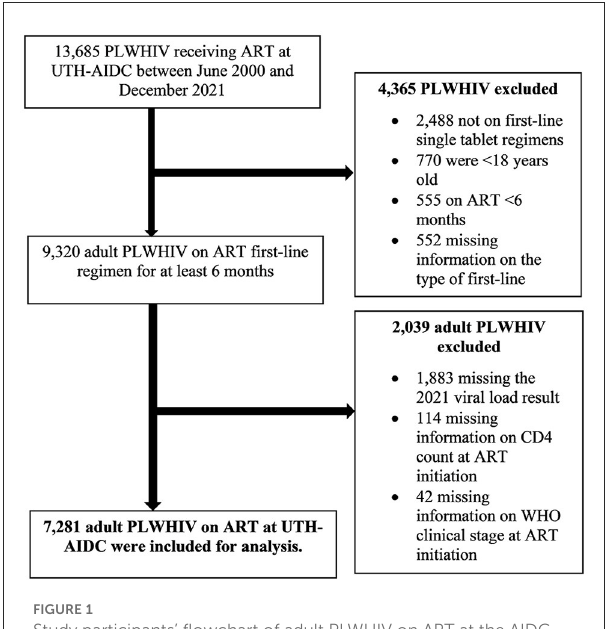
FIGURE1 Study participants’ flowchart of adult PLWHIV on ART at the AIDC, UTH,